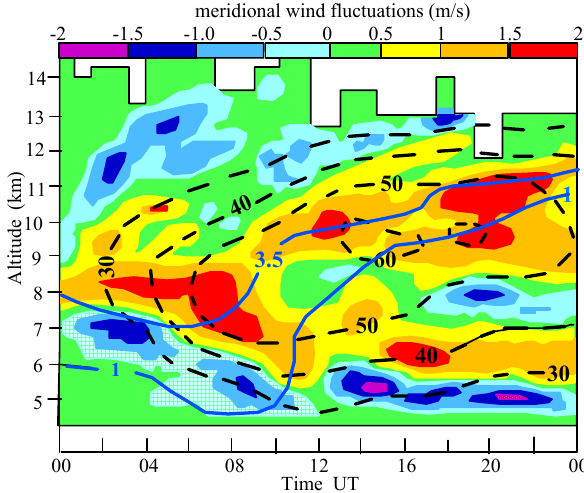
Fig. 9. Comparison of the turbulent field observed by the PROUST radar, with the stability structures detected by the Raman lidar. In order to take into account the advection of the fold, a time shift of 9 hours has been applied to the radar observations, while an altitude shift of about 0.5km has been done in order to have the best possible continuity between the isentropes defined by the ECMWF model at Saint Santin and observed by the Raman lidar at OHP site.